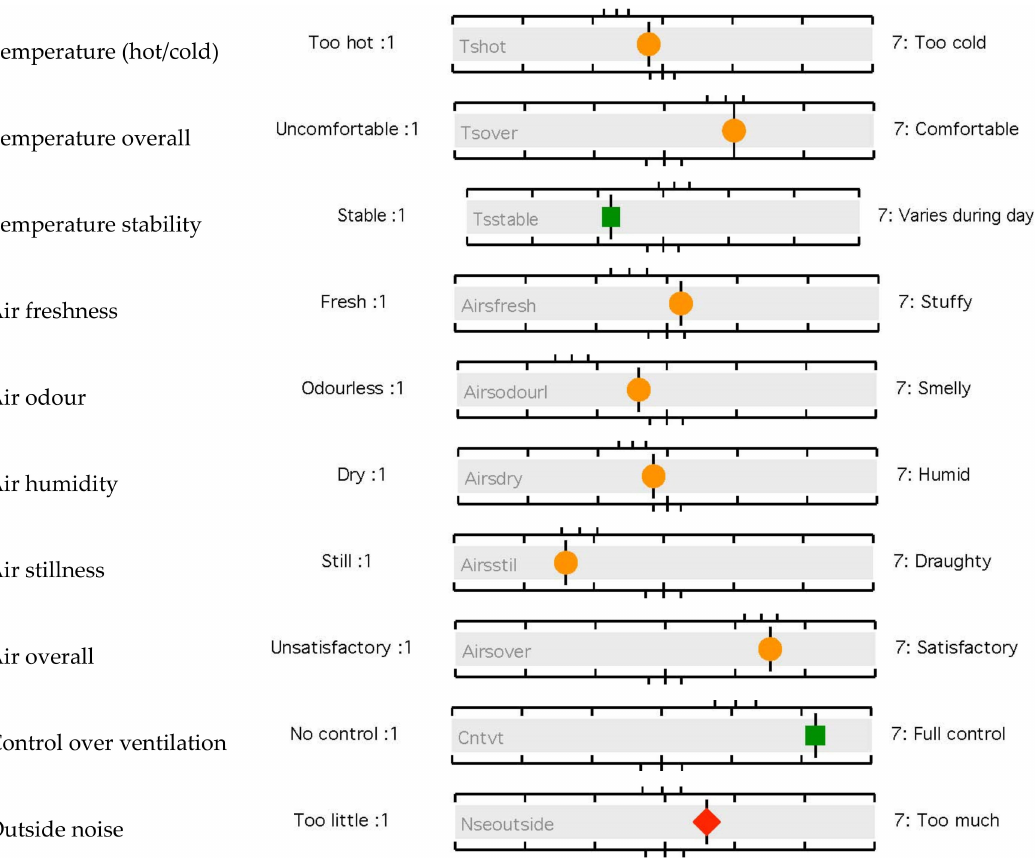
Figure 16. BUS responses for the four case study